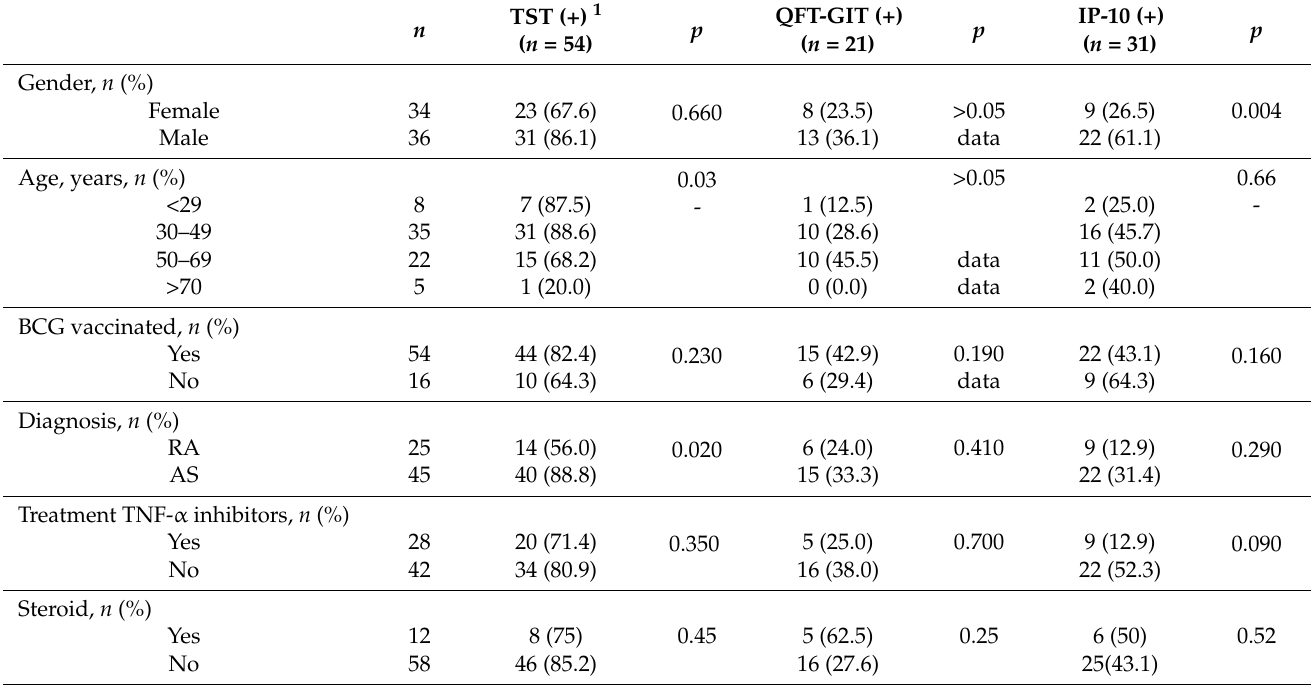
Table 2. Associations of demographic, epidemiological and clinical characteristics and therapy with QuantiFERON-TB Gold intube (QFT-GIT) and tuberculin skin test (TST) and Interferon-Inducible Protein-10 (IP-10) positive results in subjects with IRD patients.